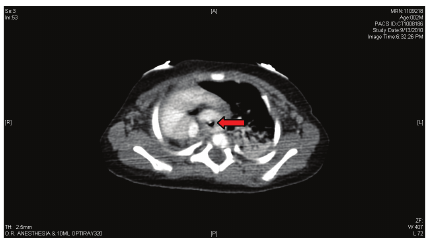
Figure 1: Tracheal compression, supine.